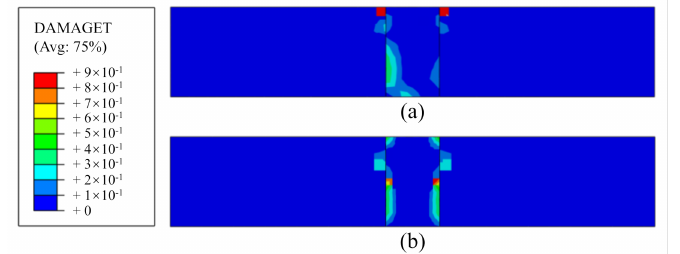
Figure 9. Contour plots of damage for ( a ) S-SWJ and ( b ) S-CWJ when the concrete–concrete interface of the specimen